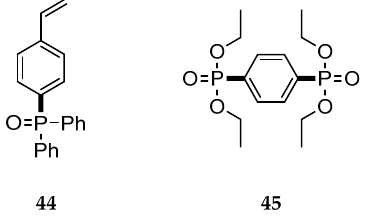
Figure 20. Phosphine oxide derivative 44 and phosphonate derivative 45 .